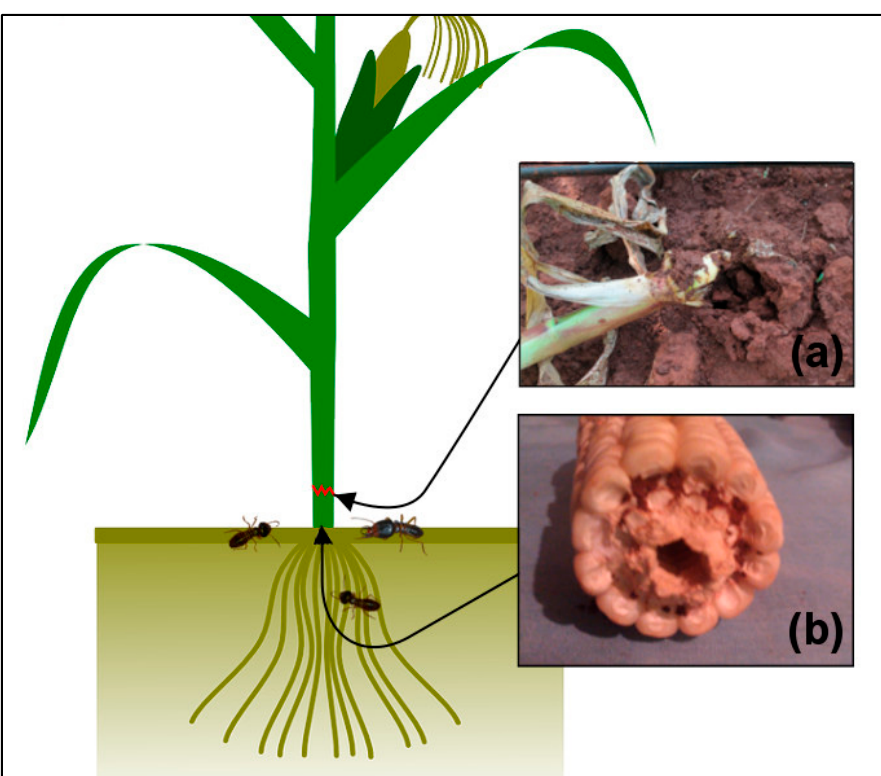
Figure 1. Lodging ( a ) and tunneling ( b ) done by termites on maize plants.